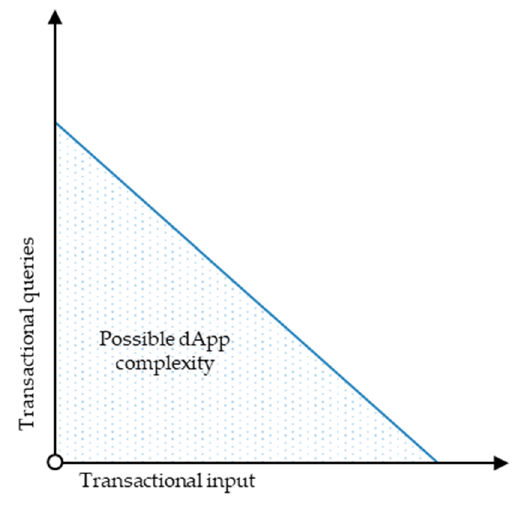
Figure 11. The dApp complexity dilemma.